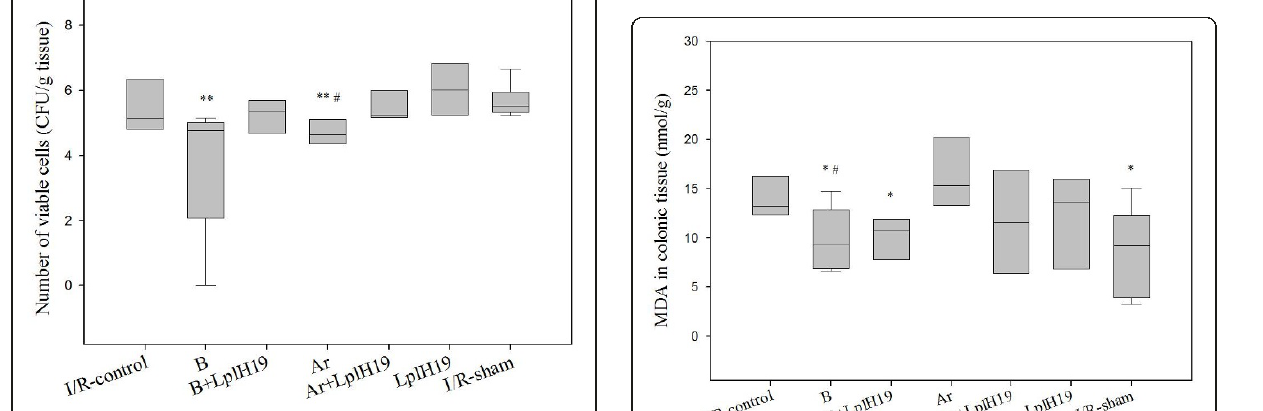
Figure 1 Lactobacilli count of colonic mucosal tissue of mice after intestinal ischemia-reperfusion . Viable count of lactobacilli of colonic mucosal tissue of mice administrated billberry (B), chokeberry (Ar) and/or strain Lactobacillus plantarum HEAL19 (LplH19). Lactobacilli count significantly decreased in Ar-group (**p = 0.008) and B-group (**p = 0.002) compared to LplH19-group. The count was higher in groups supplemented with LplH19 strain and significantly higher when LplH19 was added to chokeberry (Ar +LplH19-group) compared to only chokeberry-fed mice (Ar-group; #p = 0.029). Median values are indicated by the transverse line within the box and the top and bottom lines of each box represent the 25 th and 75 th percentiles.